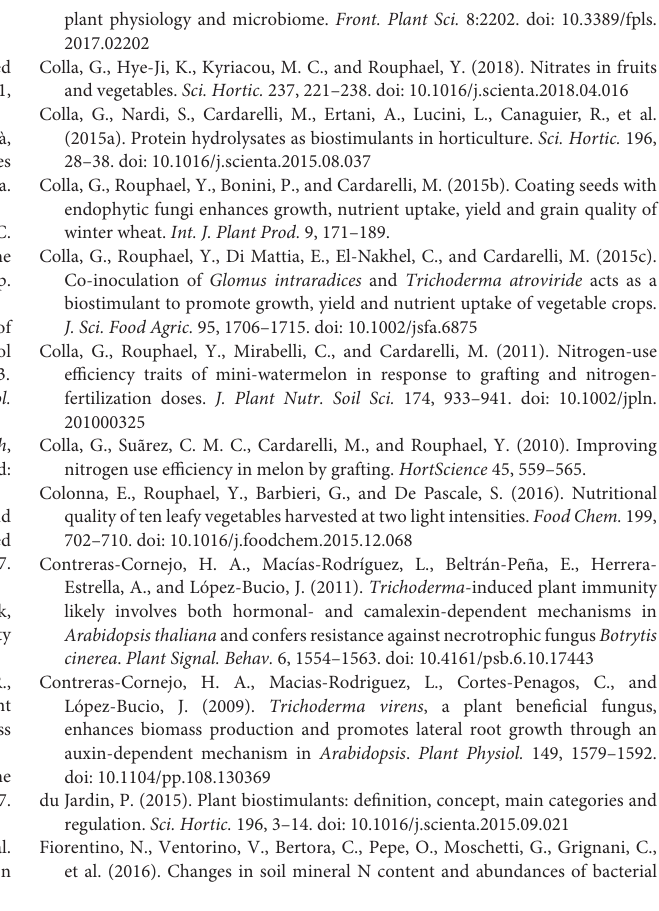
FIGURE S1 | Photos showing representative lettuce and rocket plants as affected by different N doses and Trichoderma inoculation. Low N, non-fertilized